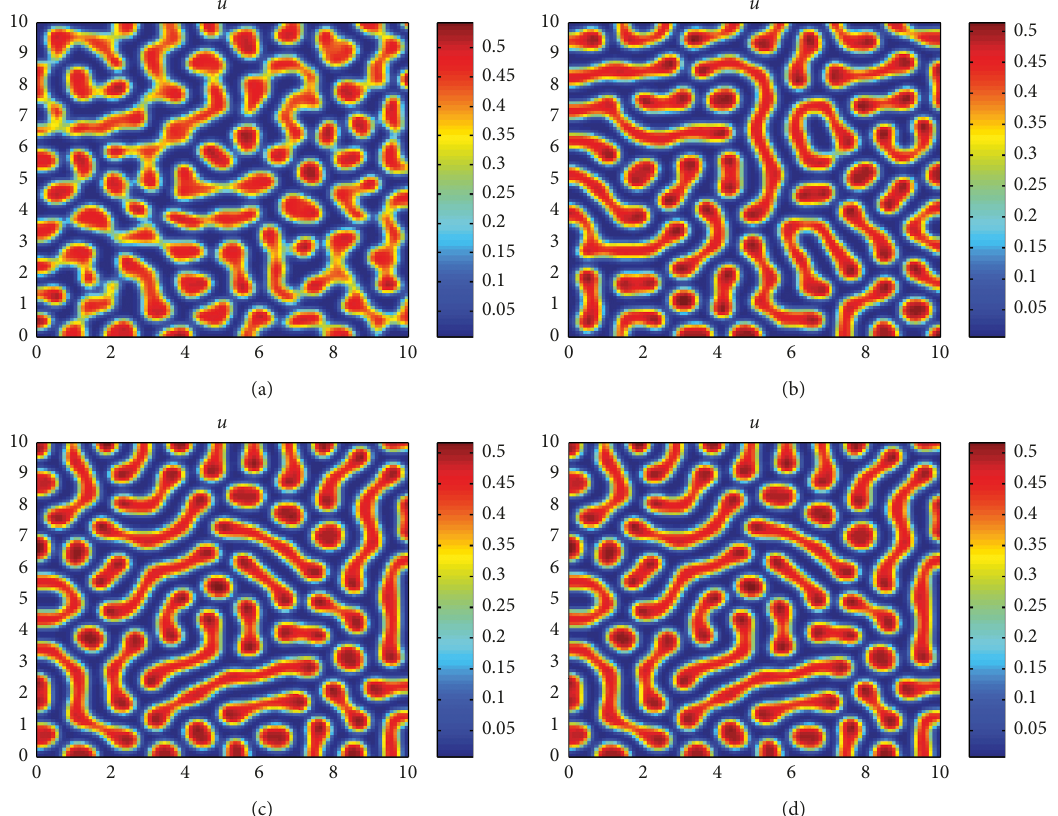
Figure 1: Mixture patterns obtained with model (1) for A � 0 and τ � 0. Time: (a) t � 100, (b) t � 500, (c) t � 2000, and (d) t �